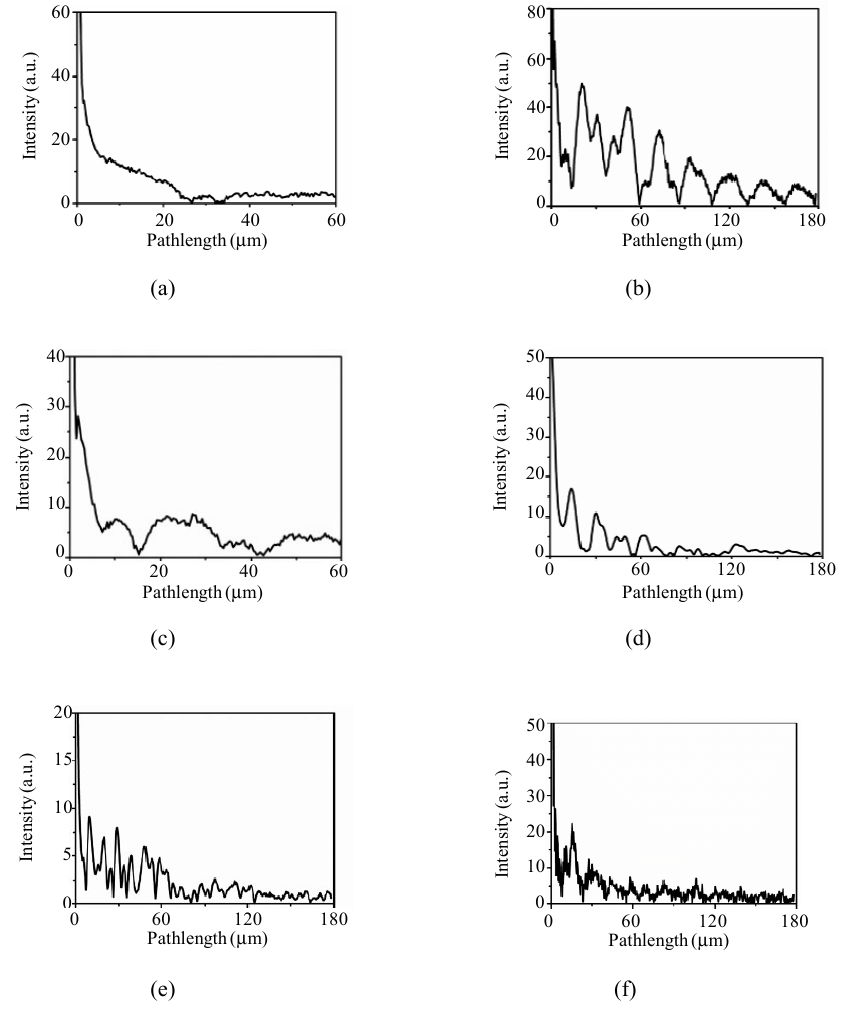
Fig. 6 Fourier transform corresponding the emission spectra of (a) 0.156 wt.%, (b) 0.234 wt.%, and (c) 0.312 wt.% dye doped vesicles in Figs. 4(a), 4(c), and 4(e), and (d) 0.156 wt.%, (e) 0.208 wt.%, and (f) 0.312 wt.% azo polymers in Figs. 5(a), 5(c), and 5(e).